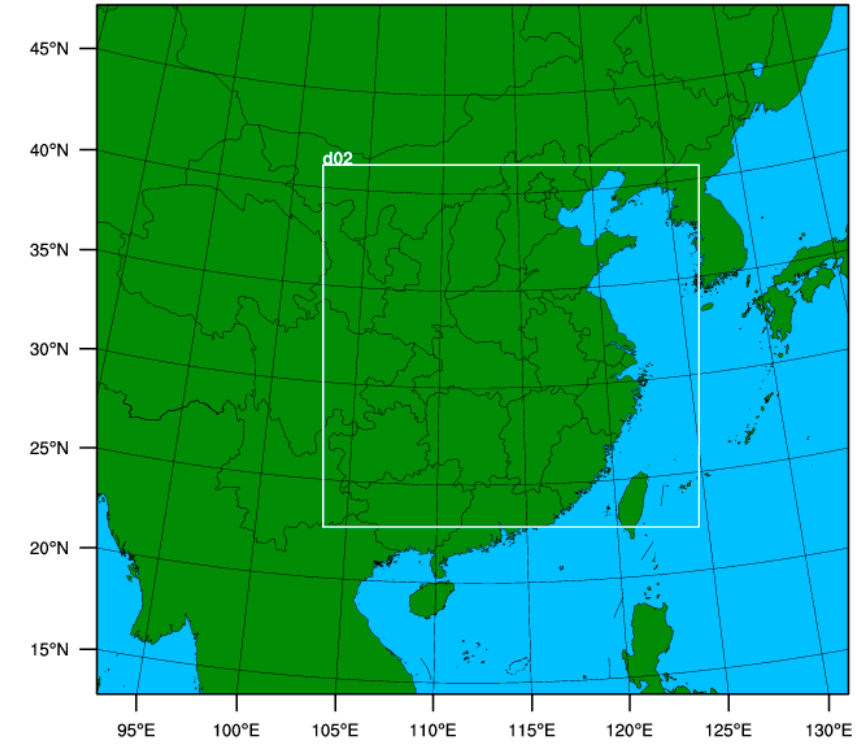
Figure 1. Experimental domain.